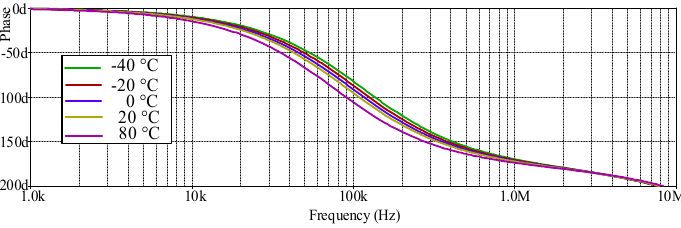
Figure 20. Frequency gain response of AP − with different temperature values.